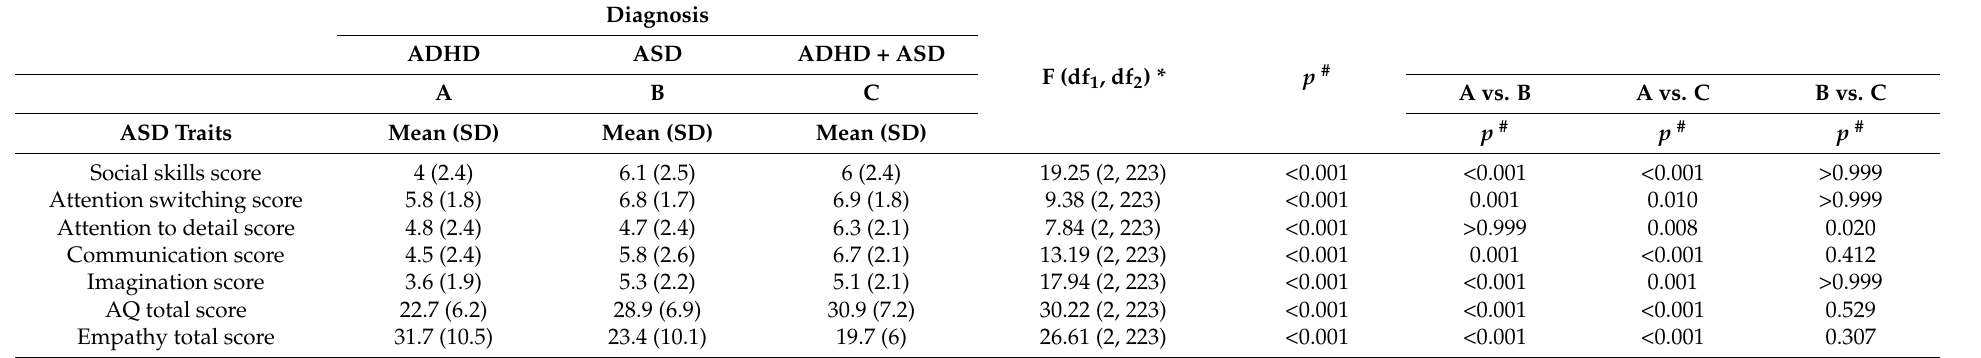
Table 3. Comparison of the self-report number of ASD traits between the three study